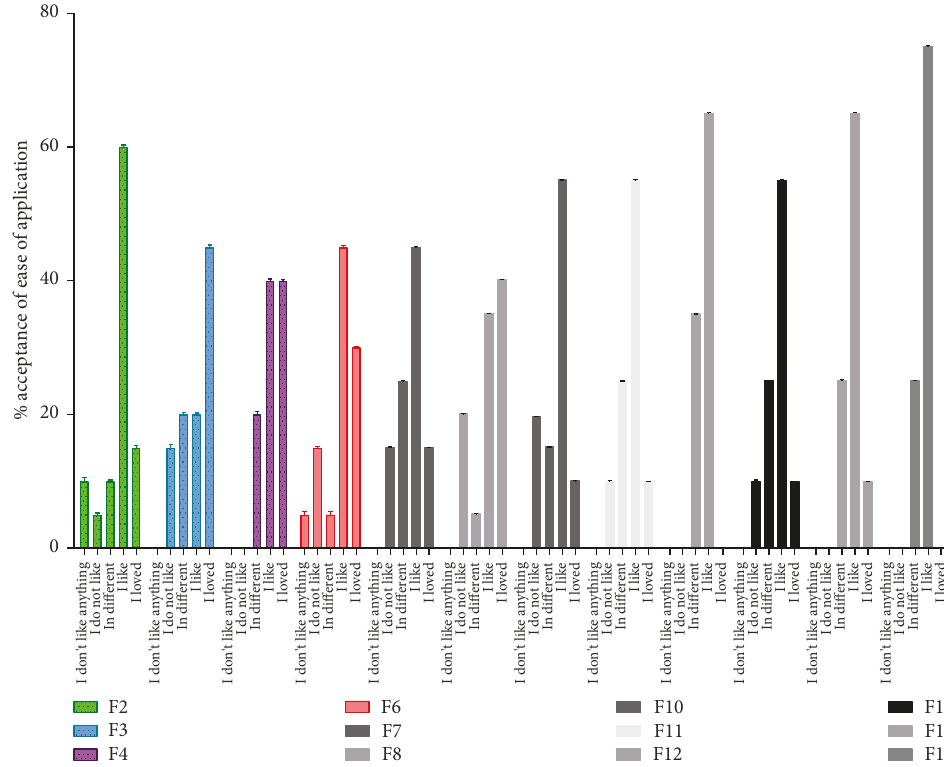
Figure 12: Acceptance percentage of ease of application by panelists for di ff erent